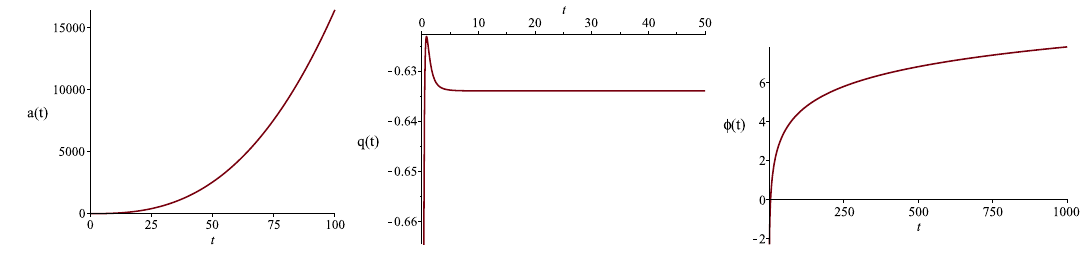
Figure 4. Plot of the quantities, a ( t ) , q and φ ( t ) . Numerical values of the constants: c 1 = − 1, c 2 = − 1, c 3 = − 1/624 and c 4 = 0. Note that the solution is inflationary and has an accelerated expansion at late time without any transition to a decelerated